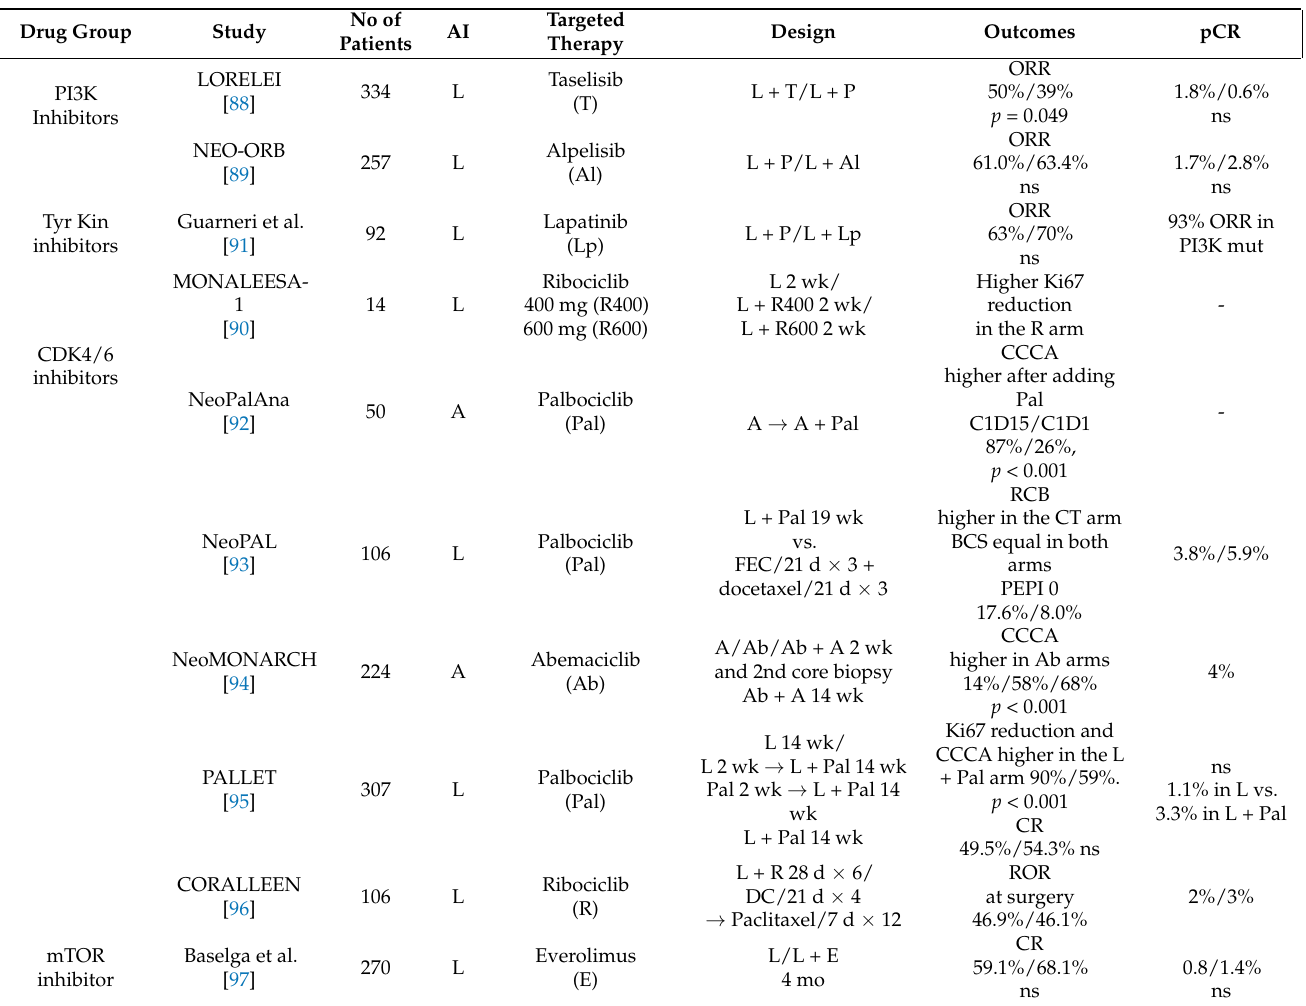
Table 5. NET and Targeted Therapies. Phase II